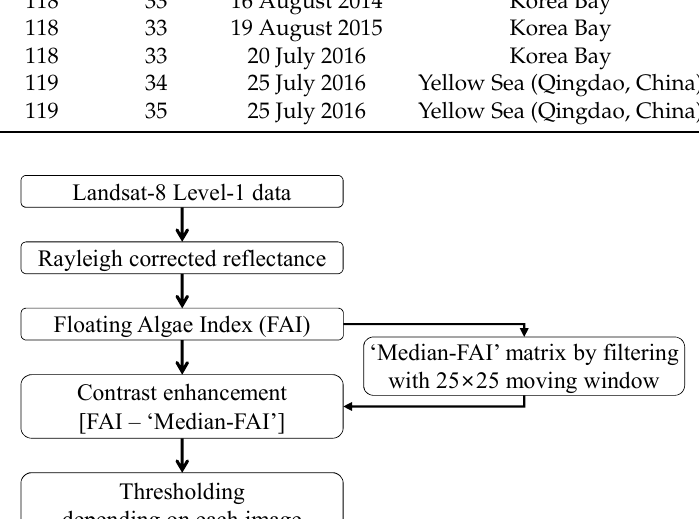
Figure 2. Flow diagram for the modified FAI-based macroalgae detection.